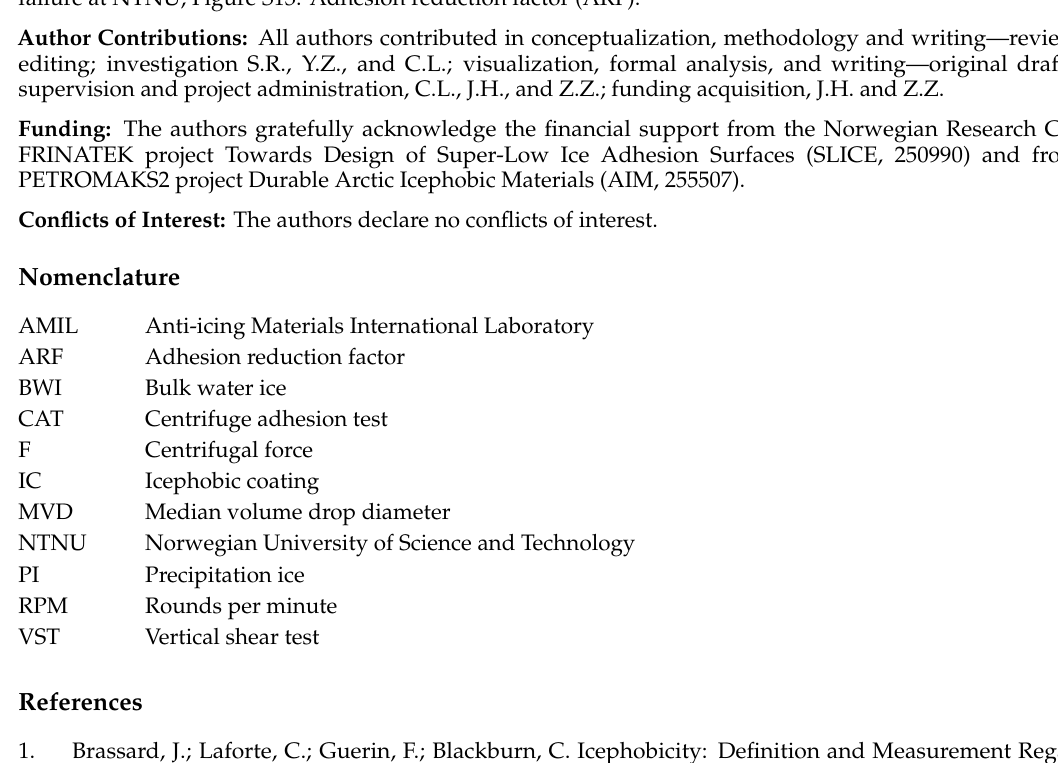
Table S1: Experimental protocol, Table S2: All experimental results, Figure S1: Formation BWI at AMIL, Figure S2 and S3: Formation BWI at NTNU, Figure S4 and S5: Typical adhesive failure at AMIL, Figure S6–S9: Typical cohesive failure at AMIL, Figure S10 and S11: Typical adhesive failure at NTNU, Figure S12: Cohesive failure at NTNU, Figure S13: Adhesion reduction factor